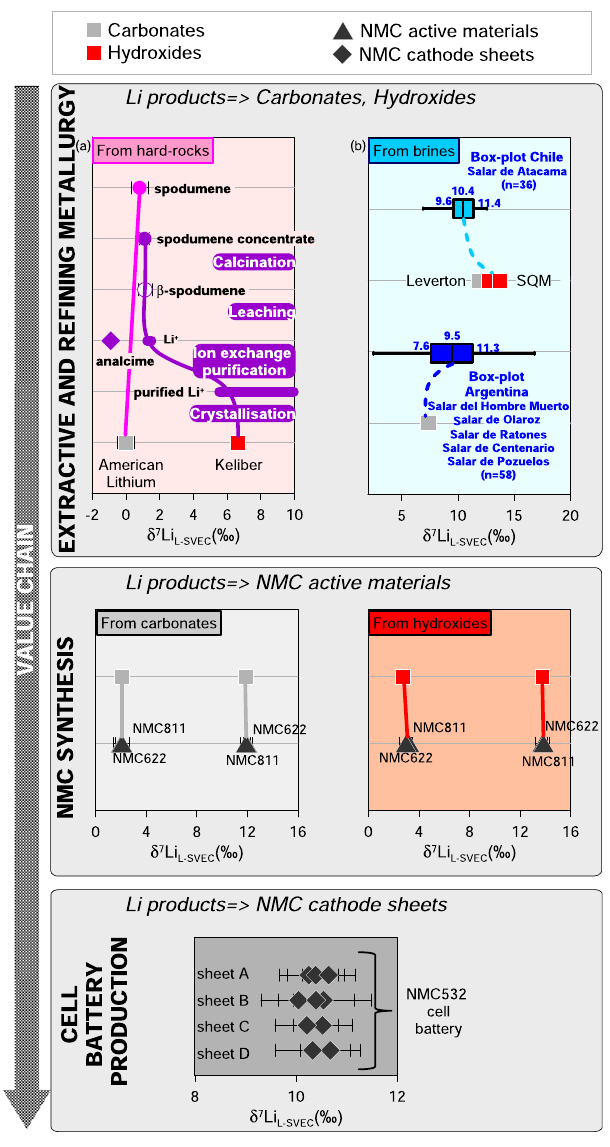
Fig. 3 Lithium isotope fractionation in various products containing Li (carbonates, hydroxides, NMC active materials, NMC cathode sheets) manufactured during the LIB production chain. Extractive and re fi ning metallurgy ( a ) for hard-rock-based lithium sources, with spodumene and Li carbonate from American Lithium, and spodumene concentrate, β - spodumene, and Li hydroxide from Keliber (this study). δ 7 Li values for Li + ( α = 1.0007, 1.0011; R = 84-94%) and puri fi ed Li + ( α = 1.055; R = 95 – 98%) are estimated as explained in the main text. b Brine-based lithium sources: Li hydroxide and -carbonate from Leverton, SQM and Alfa Aesar ( n = 5, this study). Blue box-plots are Argentinian salars ( n = 58) 35,36,38,39 and Chilean salar de Atacama ( n = 36) 37,39,40 data. NMC active materials synthesis with NMC622 ( n = 2) and NMC811 ( n = 2) produced in this study from lithium carbonate (Li13, Li18) and -hydroxide (Li01, Li17). Cell battery production with various pieces of cathode sheets ( n = 8) coming from the same NMC532 cell battery (this study). Error bars represent the 2 σ associated with δ 7 Li